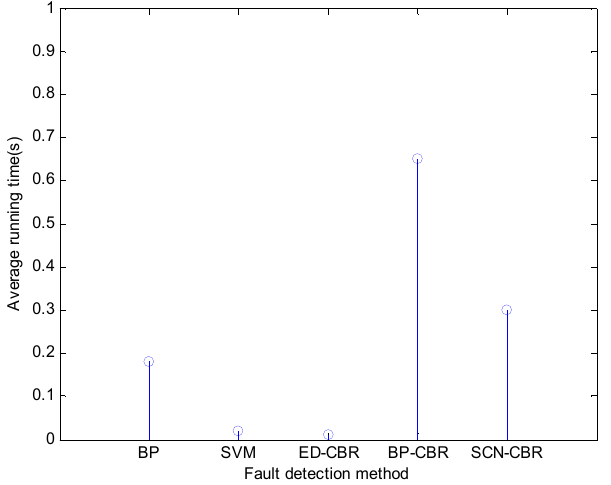
Figure 8. The running time of different methods for chamber of furnace fault detection ( s ).